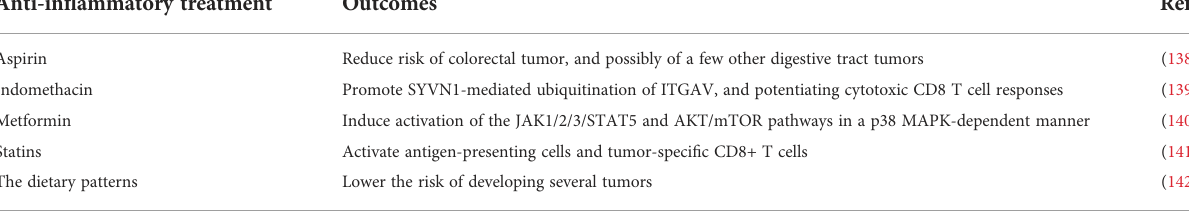
TABLE 3 Anti-in fl ammatory treatment are bene fi cial to prevent tumors. Anti-in fl ammatory treatment Outcomes